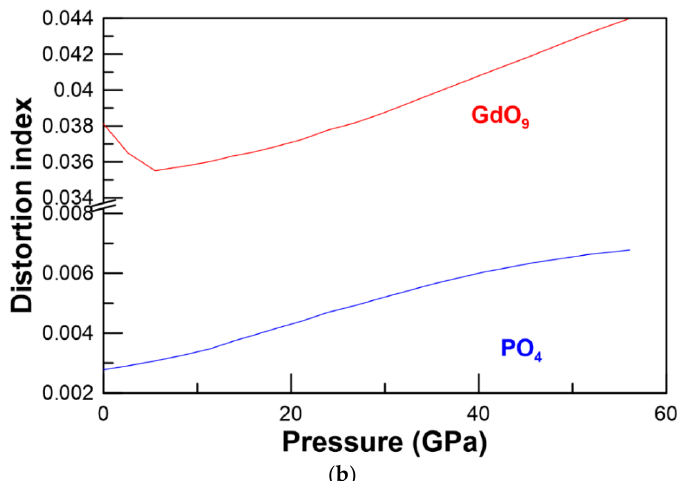
Figure 3. ( Color online ) ( a ) Relative variation with pressure of the polyhedral and unit cell volumes of monazite-type GdPO 4 . ( b ) Distortion index of the PO 4 tetrahedron and the GdO 9 polyhedron.